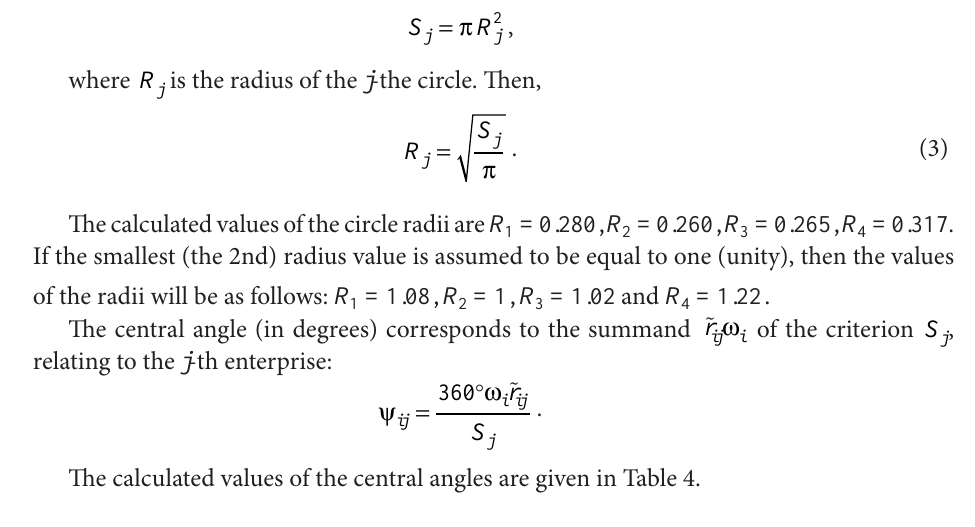
Table 4. The values of the central angles of sectors No.